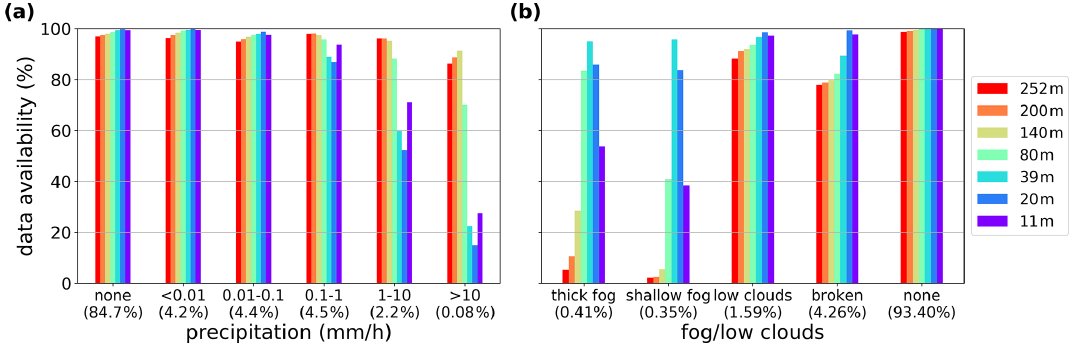
Figure 6. QC data availability of the wind lidar for (a) different classes of precipitation intensity and (b) presence of fog or low clouds (in the absence of precipitation). The colours indicate the measuring heights (see legend). Percentages between brackets are the occurrences of the